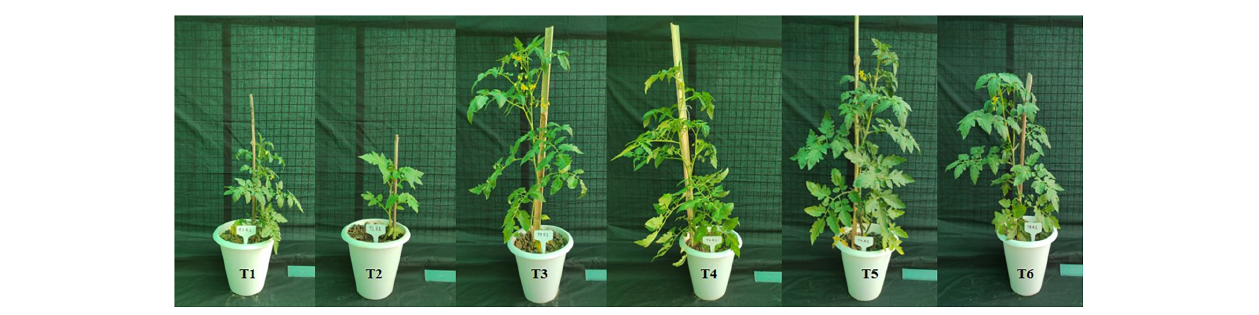
FIGURE 10 | Growth of tomato plants (V1) obtained after 45 days of sowing of tomato seeds of all the treatments: T1 (Surface-sterilized seeds only); T2 (Surface-sterilized seeds + fungal pathogen); T3 (Bio-primed seeds only); T4 (Bio-primed seeds + fungal pathogen); T5 (Bio-primed seeds + fungal pathogen + soil treatment of the bacterial strain NKIT9); T6 (Chemical treated seeds (Bavistin-Carbendazim) + fungal pathogen.